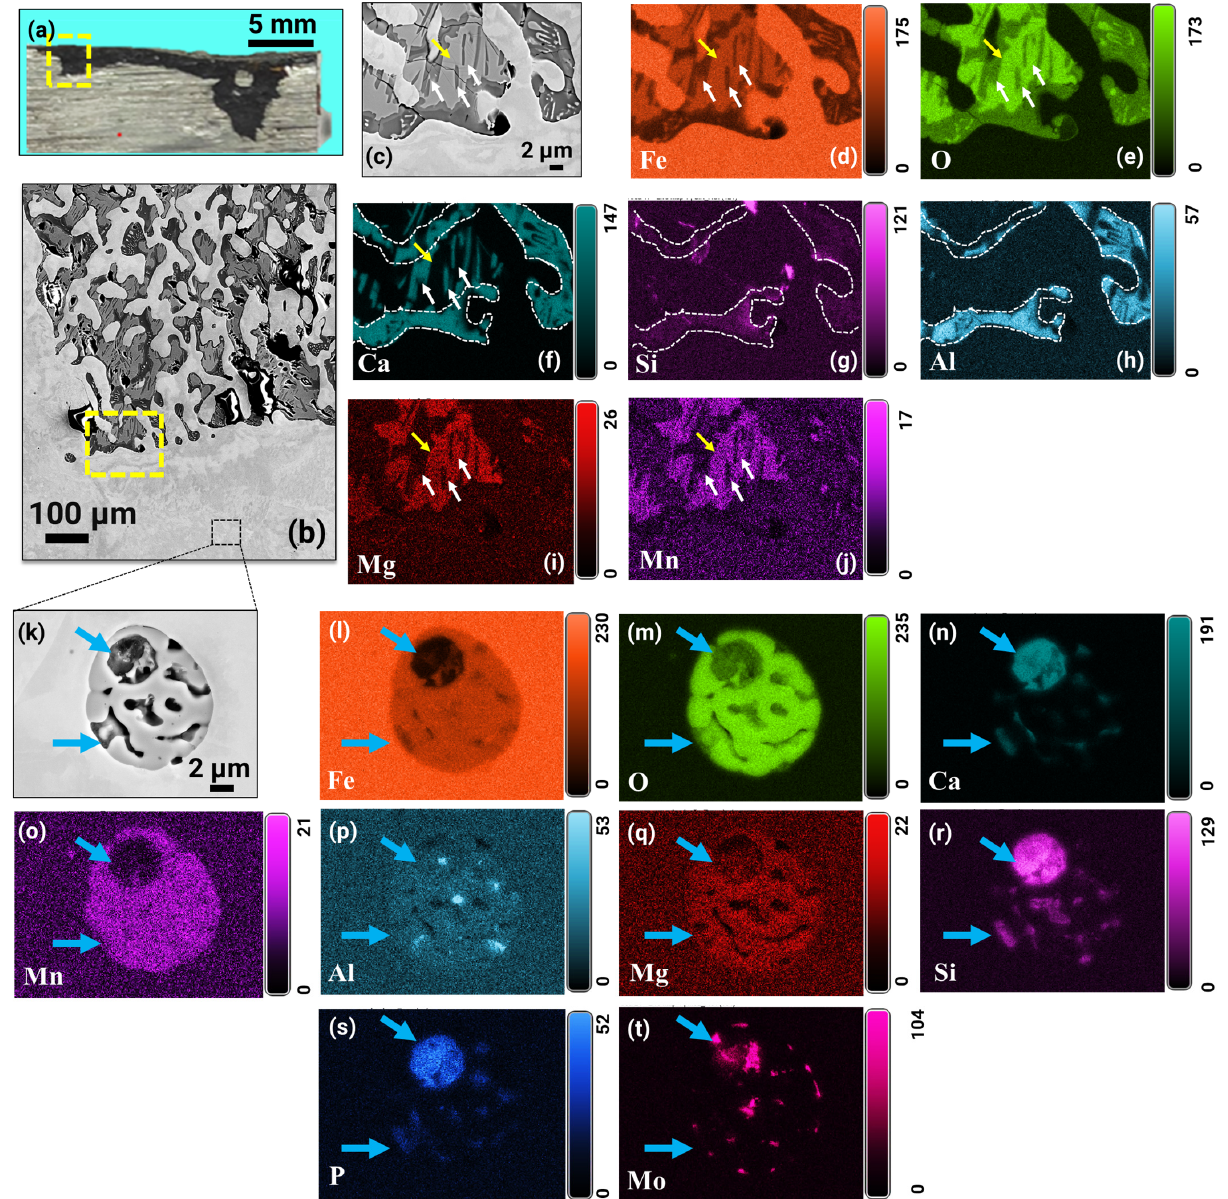
Figure 10. Microstructural characterization of the reduced and smelted EC ore sample. ( a ) Overview of the processed specimen. The red frame in this figure indicates the area probed using SEM. ( b ) SE image of the area marked by the red frame in ( a ). ( c ) Enlarged view of the solidified domains across the slag–metal interface. The spatial elemental distribution maps for the area probed under EDX are shown in ( c ), corresponding to ( d ) Fe, ( e ) O, ( f ) Ca, ( g ) Si, ( h ), Al, ( i ) Mg and ( j ) Mn. ( k ) SE image of a typical oxide found inside the iron. The elemental distribution maps show the local chemical partitioning inside this particle for ( l ) Fe, ( m ) O, ( n ) Ca, ( o ) Mn, ( p ) Al, ( q ) Mg, ( r ) Si, ( s ) P, and ( t ) Mo.